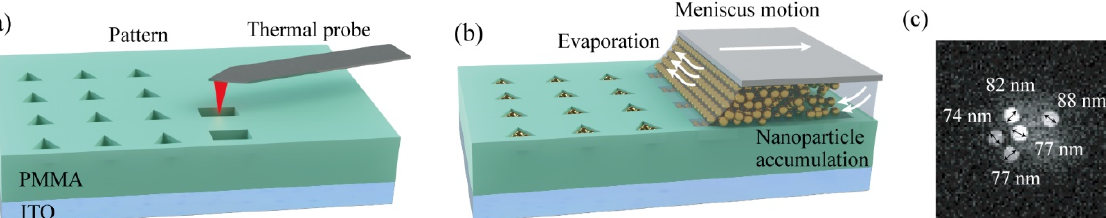
Figure 5. Fabrication of the template and process of capillary-assisted assembly of AuNPs. ( a ) Tem- plate fabrication: the designed PMMA template is defined by thermal probe writing. ( b ) Nanoparticle self-assembly: AuNPs accumulate on the pattern via the self-assembly process. ( c ) SEM image of assembled AuNPs on PMMA template, which shows the average lateral dimension of the assembled AuNPs is approximately 80 nm.